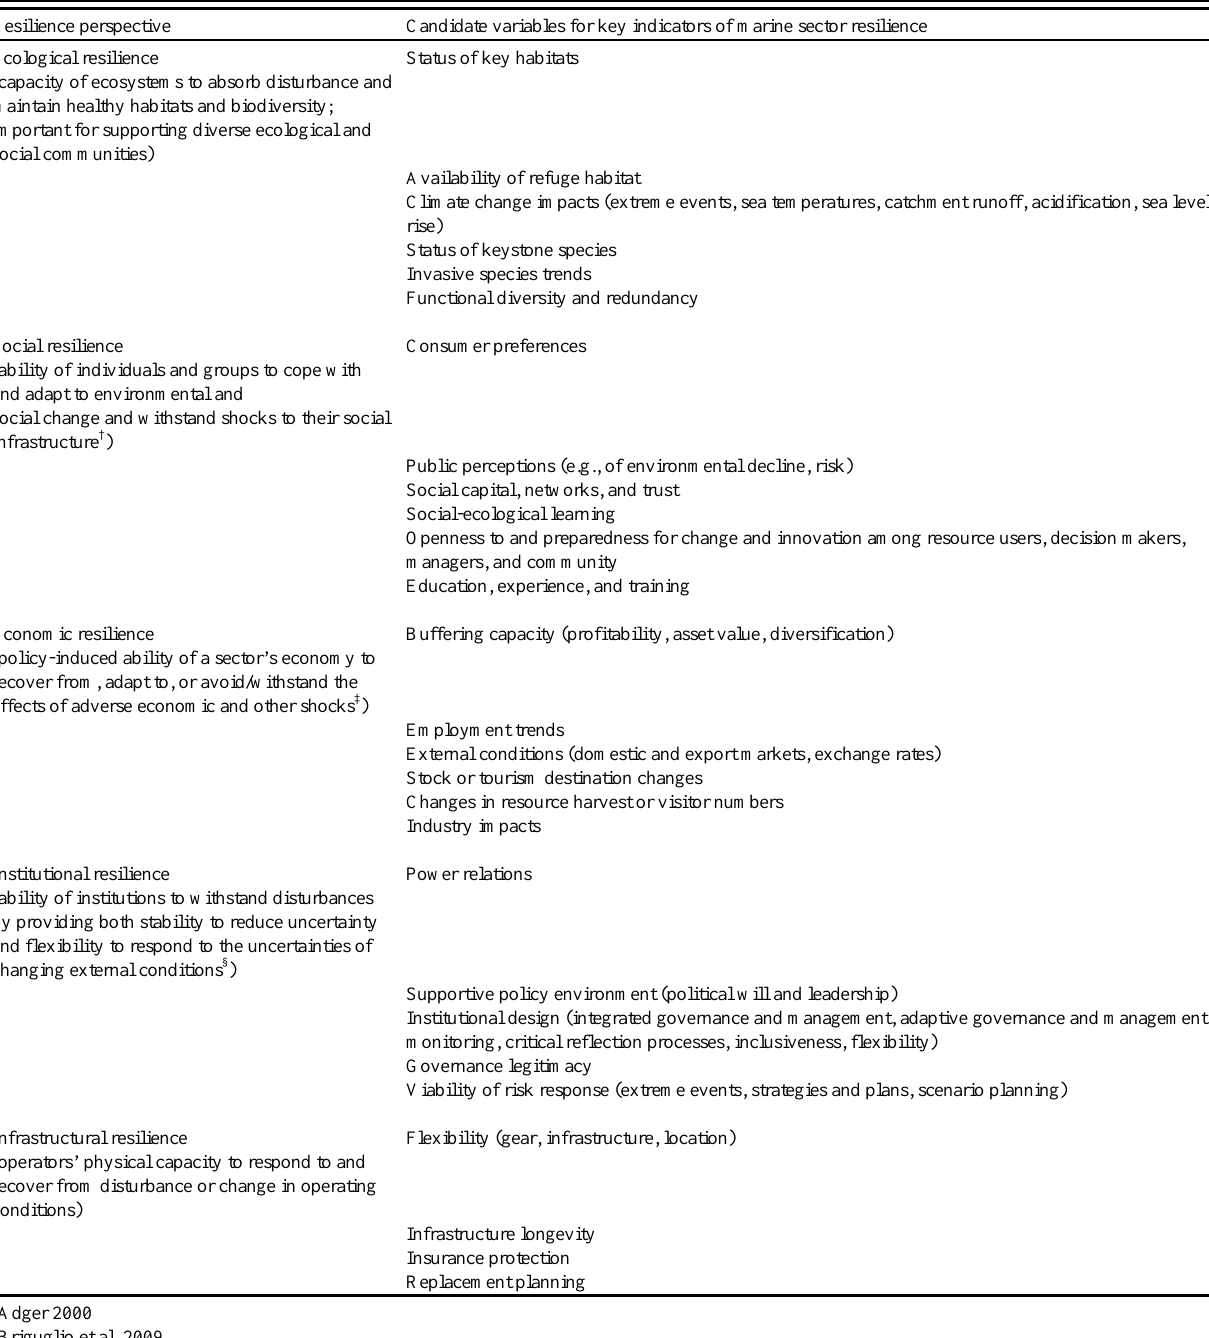
Table 5 . Potential key